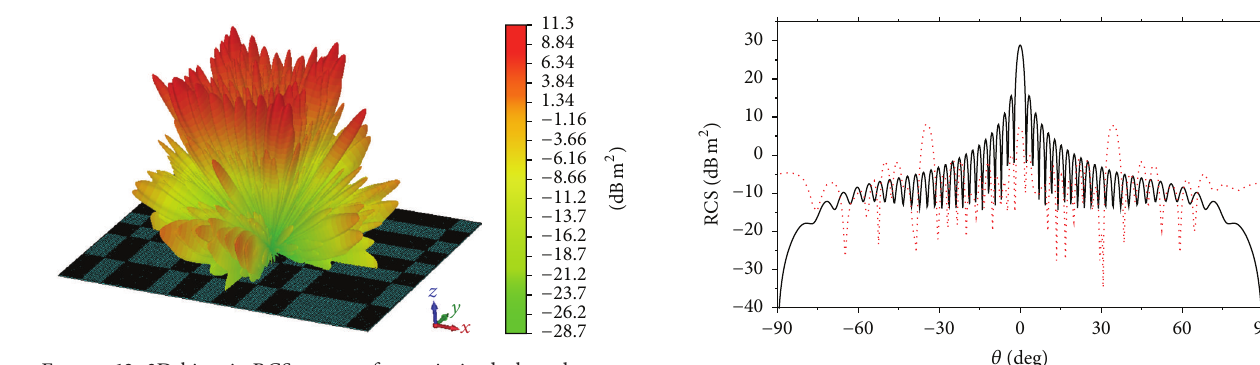
Figure 12: 3D bistatic RCS pattern for optimized phase layout at 17GHz.